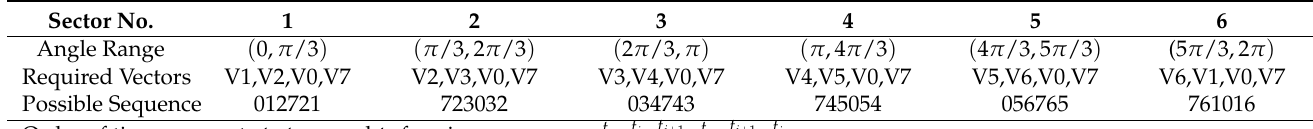
Table 1. Switching details for the SVPWM